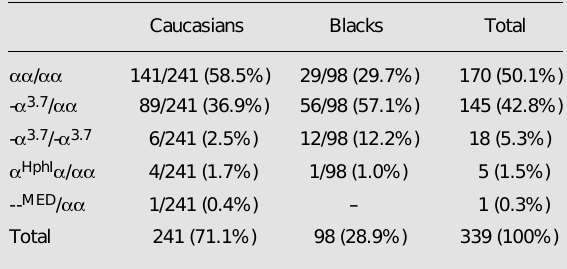
Table 1. Genotypes found among 339 individuals with microcyto- sis and hypochromia without